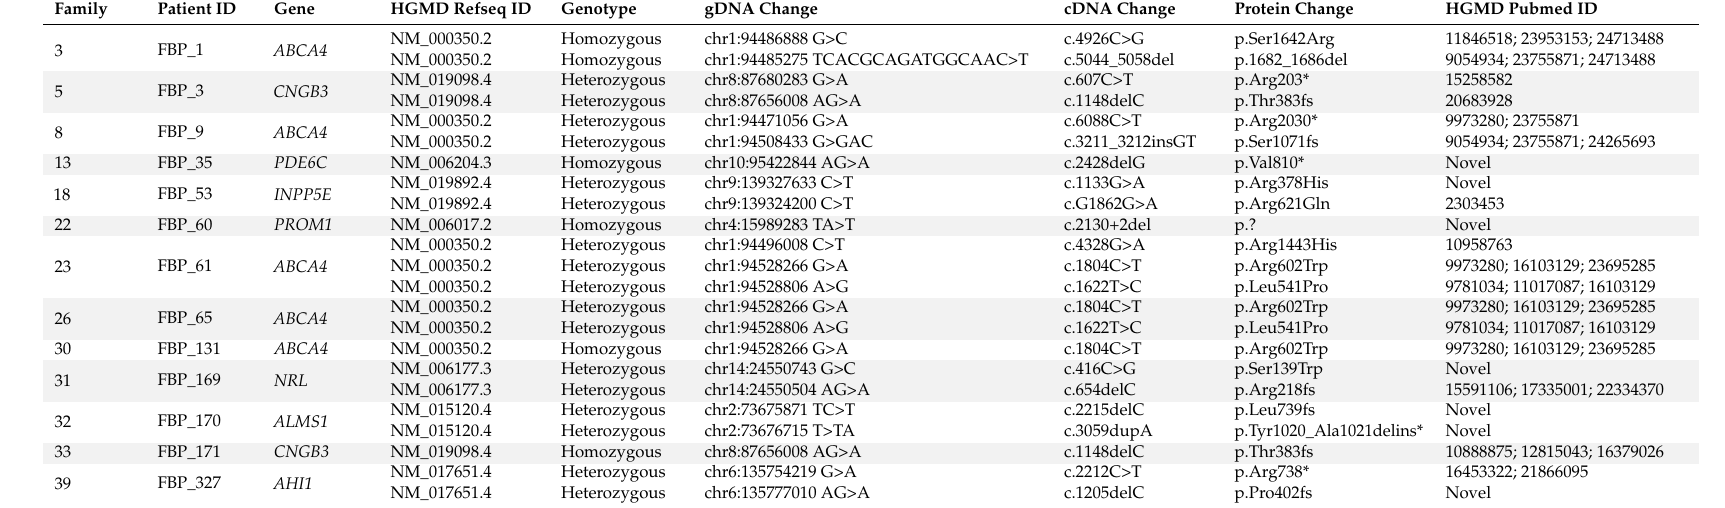
Table 3. Thirteen unrelated Brazilian Probands diagnosed with LCA or EOSRD and solved by mutations in retinal disease genes not typically associated with LCA.